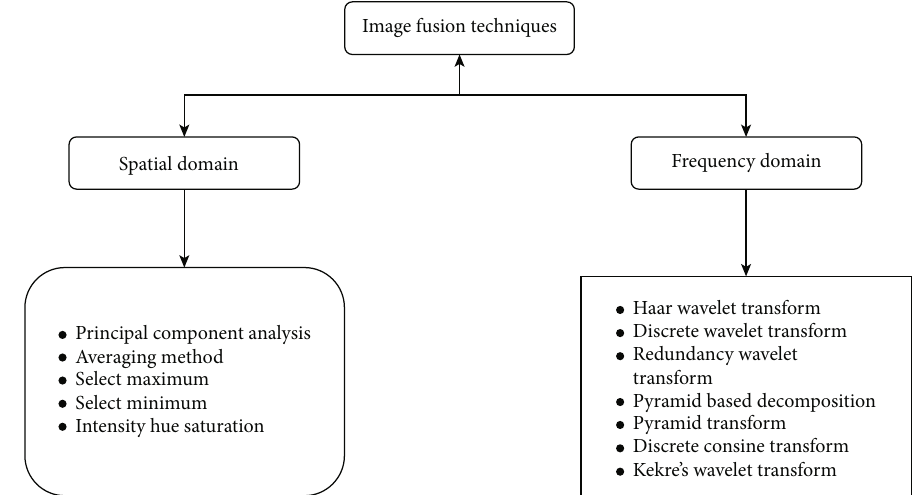
Figure 2: Methods adopted to perform image